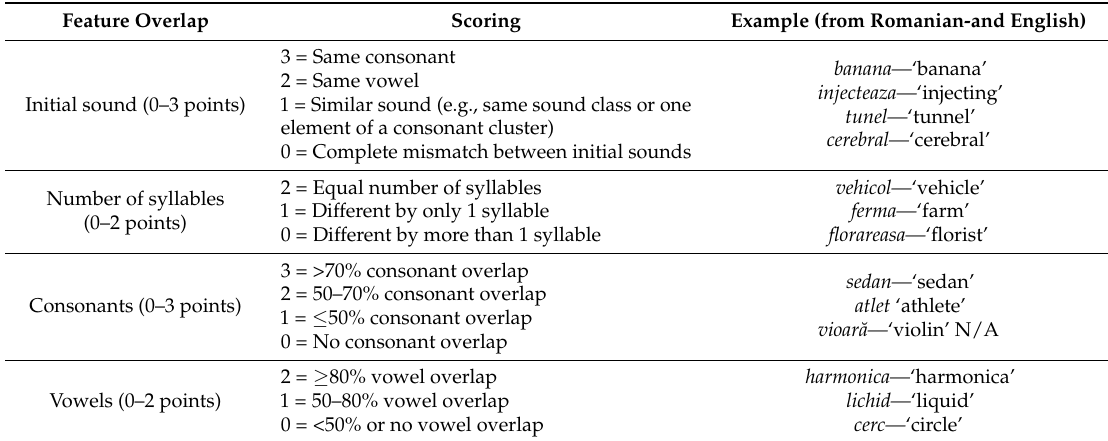
Table 1. Cross-linguistic overlap scale for phonology to determine cognate status.